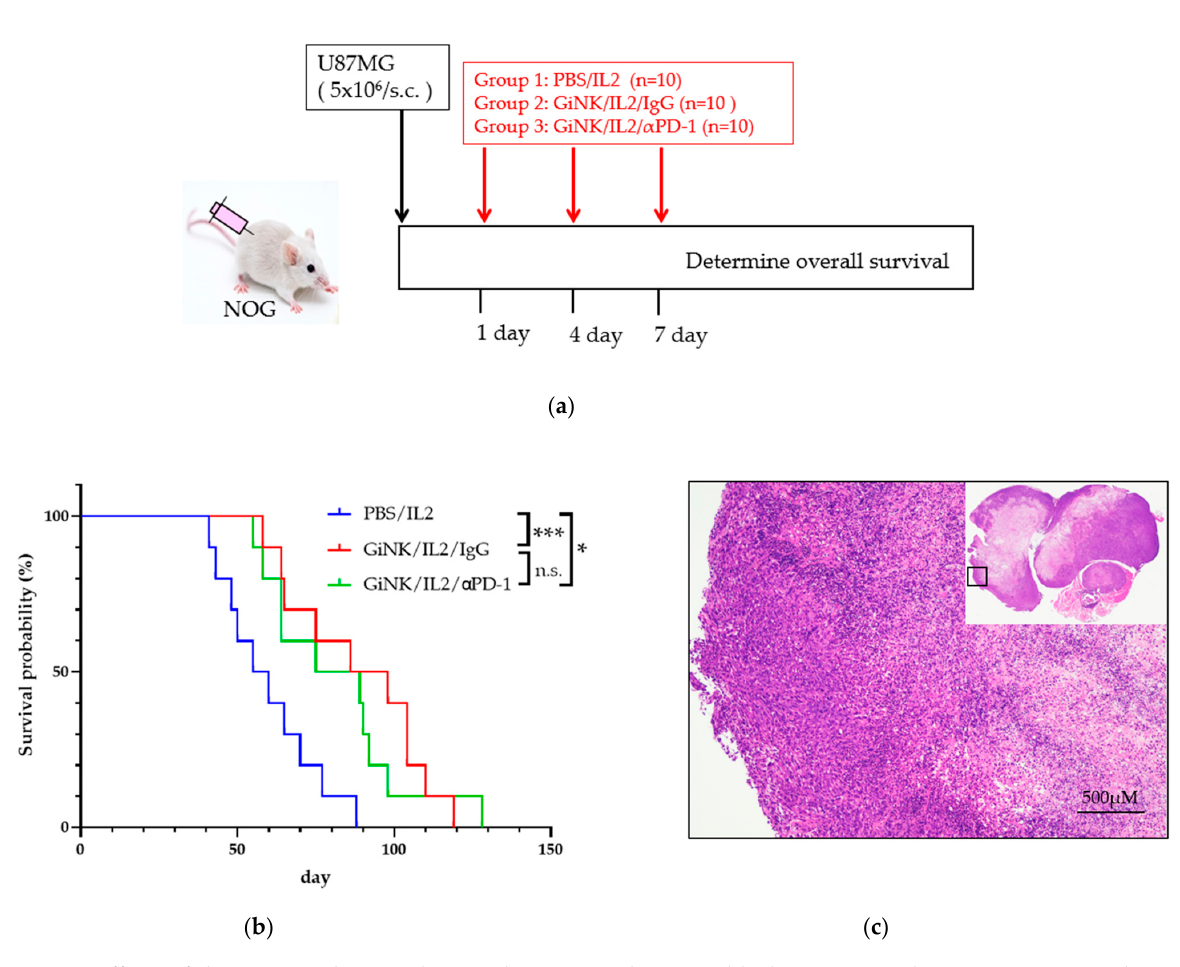
Figure 5. Effects of the GiNKs when used in combination with a PD-1 blocker against subcutaneous tumors derived from GBM-like cells. ( a ) Picture showing the experimental design. A total of 5 × 10 6 U87MG cells were subcutaneously injected into the backs of NOG mice. The mice were then randomly assigned to three subcutaneous injection groups: PBS/IL-2 (10,000 IU/mL), GiNKs (10 7 )/IL-2 /IgG (40 µ g), or GiNK/IL-2/PD-1 blocker (40 µ g). The cells and drugs were injected intravenously via the retro-orbital sinus (retro-orbital injection) ( b ) The graph shows the Kaplan–Meier curve. Blue, red, and green lines represent the PBS/IL2 ( n = 10), GiNK/IL-2/IgG ( n = 10) and GiNK/IL2/PD-1 blocker ( n = 10) groups, respectively. Statistical significance was determined using a Log-rank test. *** and * indicate p < 0.005 and p < 0.05, respectively. Not significant indicates n.s. ( c ) The picture shows hematoxylin & eosin stained a part of subcutaneous tumor derived from U87MG cells. (Upper right: entire subcutaneous